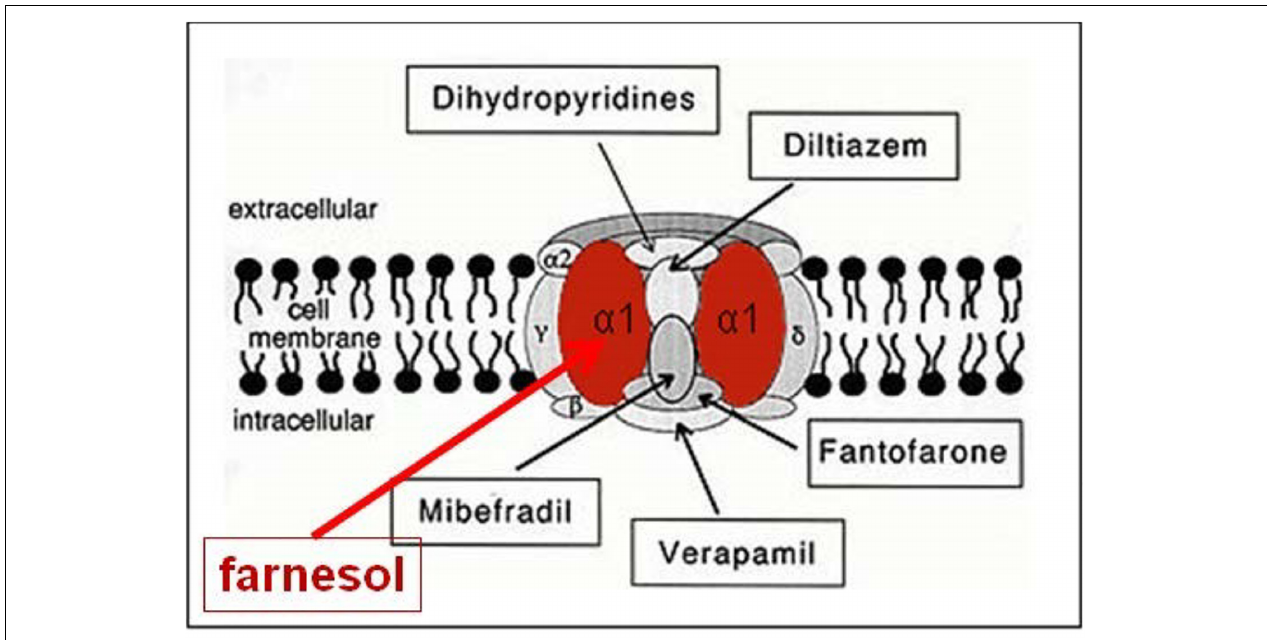
FIGURE 6 | Farnesol is an inhibitor of some types of voltage-gated Ca 2 + channels. Roullet et al., 1999, and Luft et al., 1999 demonstrated for the first time that farnesol binds to the α 1 subunit, which is the pore forming unit of voltage-gated Ca 2 + channels. Ligands for the other subunits are well documented (Figure modified after Wikipedia: Calcium channel). Copyright permission not required.